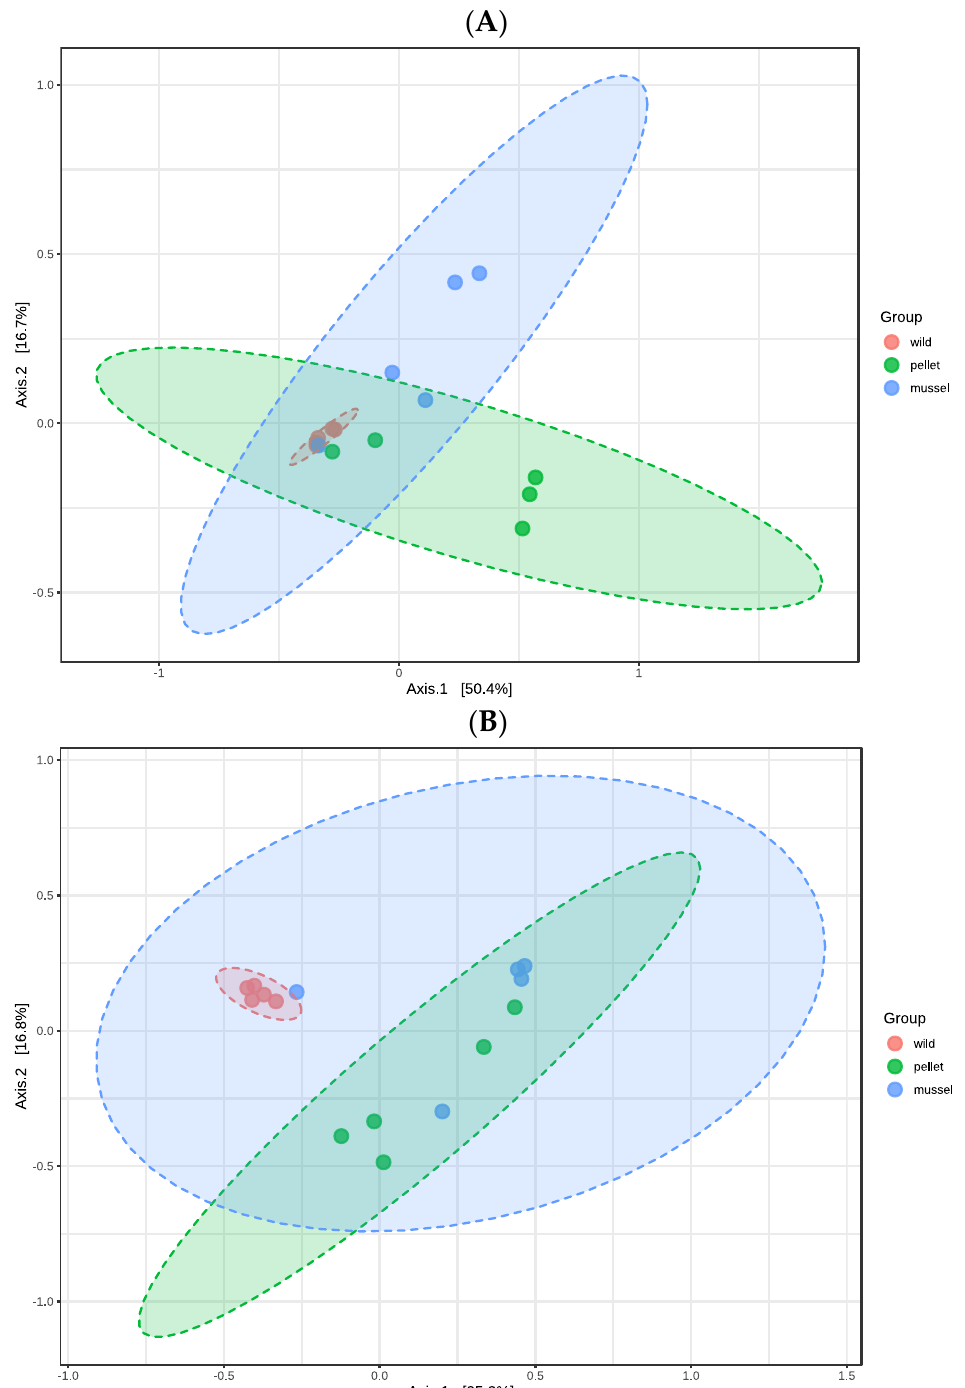
Figure 1. Principal coordinate analysis plots showing similarity in the ( A ) hindgut ( p = 0.009) and ( B ) hepatopancreas sequence libraries ( p = 0.002) of P. ornatus at species level.